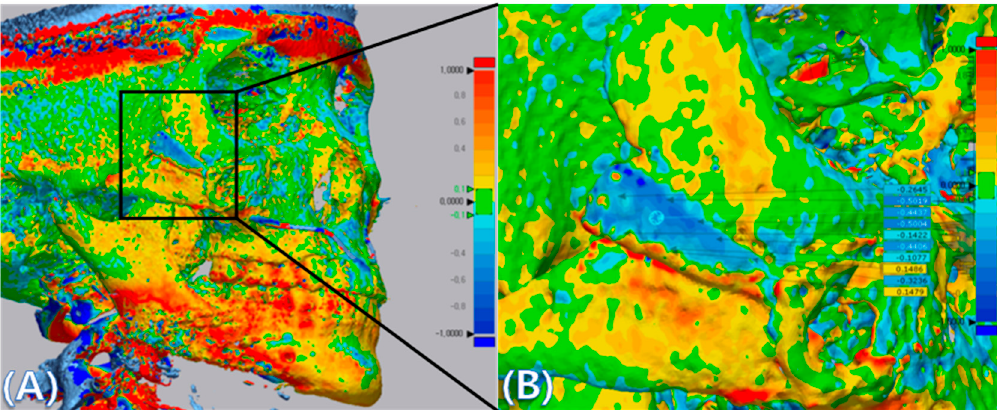
Figure 3. ( A ) CT data were converted into stereolithography (STL) files and imported into Geomagic Control X, and superimposition of CT data taken immediate post surgery (reference data) and CT data taken at 6 months after surgery (measured data) was performed using the Geomagic Control X software. The images were positioned using both the Initial Alignment and Best-Fit Alignment tools. The colors show overlays of 2 CT scan data. ( B ) Deviations between reference data and measured data were measured at ten evenly spaced points on the implants. The specific values of deviation on the implants are demonstrated. The value of deviation across the entire scan is color-graded from 1 mm (blue) to +1 mm (red).